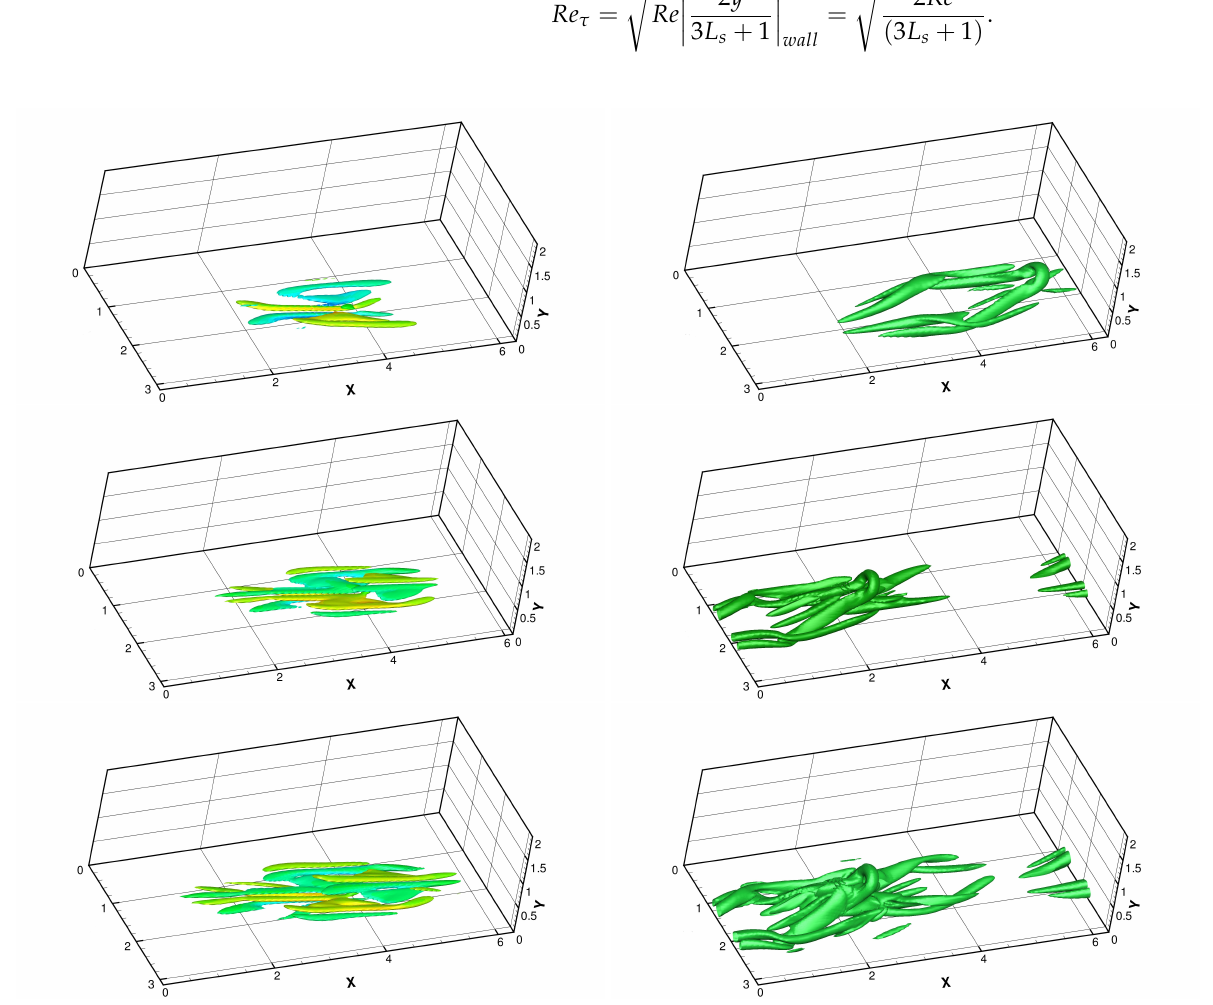
Figure 7. Nonlinear optimal perturbations for T = 10 and ( top ) E 0 = 2 E 0 = 5 10 − 6 . Isosurfaces of the Q-criterion coloured by the streamwise vorticity: Q = 0.01 at t = 0 ( left frames) and × Q = 0.2 at t = 10 ( right